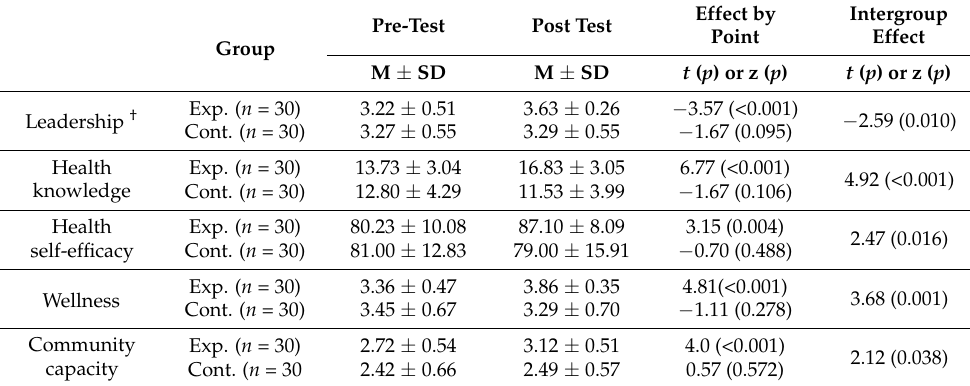
Table 3. Effect of the community capacity building